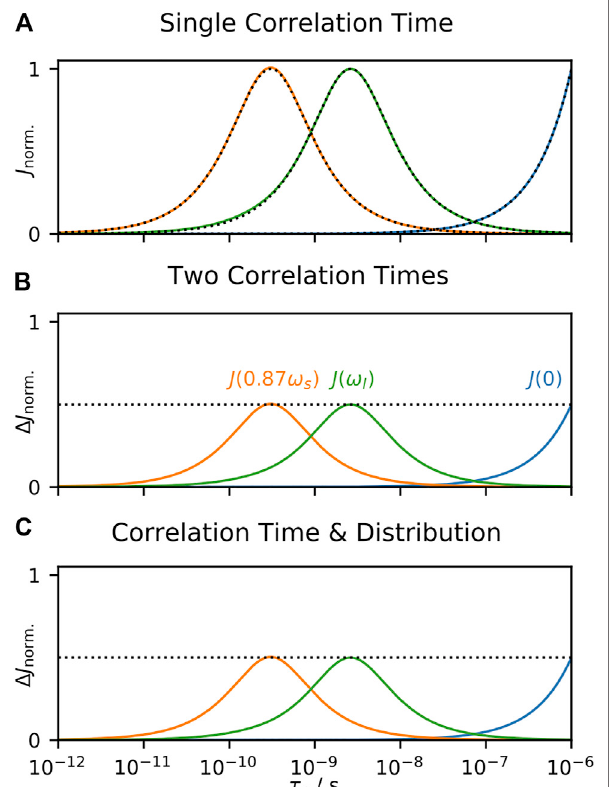
FIGURE 6 | Behavior of SDM as a function of correlation time. In each subplot, we calculate 15 N T 1 , T 2 , and σ NH at 600 MHz, and analyze the results using Eq. 21 . In (A) , the input total correlation function consists of a single decaying exponential term (with amplitude 1), where the terms J (cid:10) ω (cid:11) are plotted as the correlation time is varied (results are normalized). Black dotted linesshowthespectraldensities, J (cid:10) 0 (cid:11) , J (cid:10) ω I (cid:11) , J (cid:10) 0 . 870 ω S (cid:11) ,calculatedwith Eq. 22 , and colored lines show the results of the data analysis, yielding an almost exact correspondence. In (B) , the total correlation function now uses two correlation times (equal amplitudes), with one fi xed at 10 ps, and the second swept ( x -axis). On the y -axis, we plot contribution to the terms, Δ J (cid:10) ω (cid:11) , from the correlation time being varied. The resulting behavior is identical to that in (A) , except that the amplitude is half as large, since we have split the total amplitude between the fi xed and variable correlation time (dashed line marks 0.5). In (C) , the same information is plotted, but the total correlation function includes a log-Gaussian distribution ( μ (cid:2) 630 ps, σ (cid:2) 1 order of magnitude), and a single, variable correlation time.